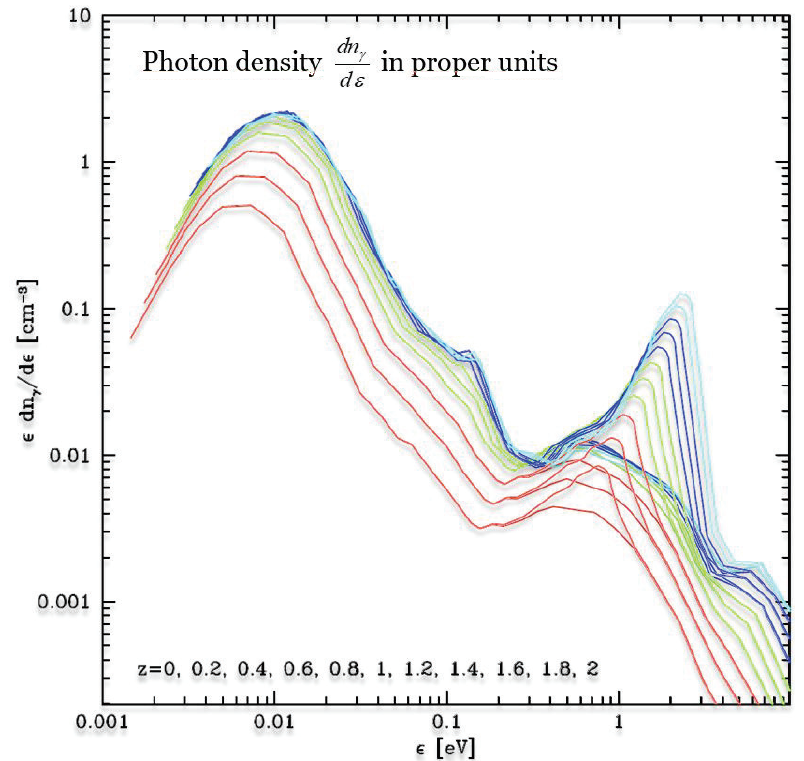
Figure 7. Energy-weighted proper number density of EBL photons as a function of the energy (cid:101) and for various redshifts. The standard EBL evolution, as in Figure 2, is compared to the densities when including photons from primeval objects: an excess local background by less than a factor 2 at 1.4 µ m becomes a factor 50 by z = 2 due to the ( 1 + z ) 3 increase in the proper photon density. The color palette for the lines is the same as in Figure